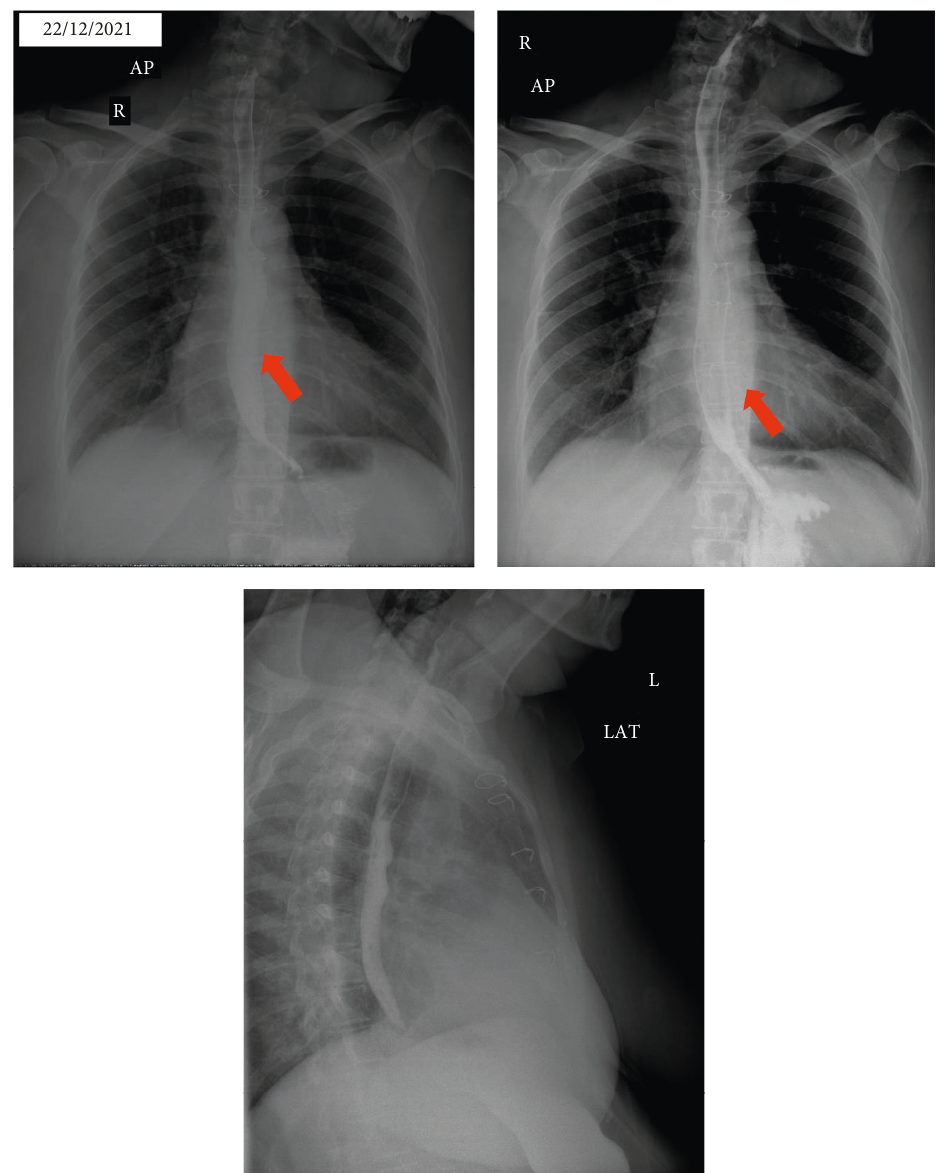
Figure 3: Anteroposterior (AP) and lateral (LAT) chest radiography after barium ingestion showed a mildly dilated and irregular esophageal lumen causing asymmetric wall thickness, especially in anteroposterior projection (red arrows) (date performed: December 22, 2021) .